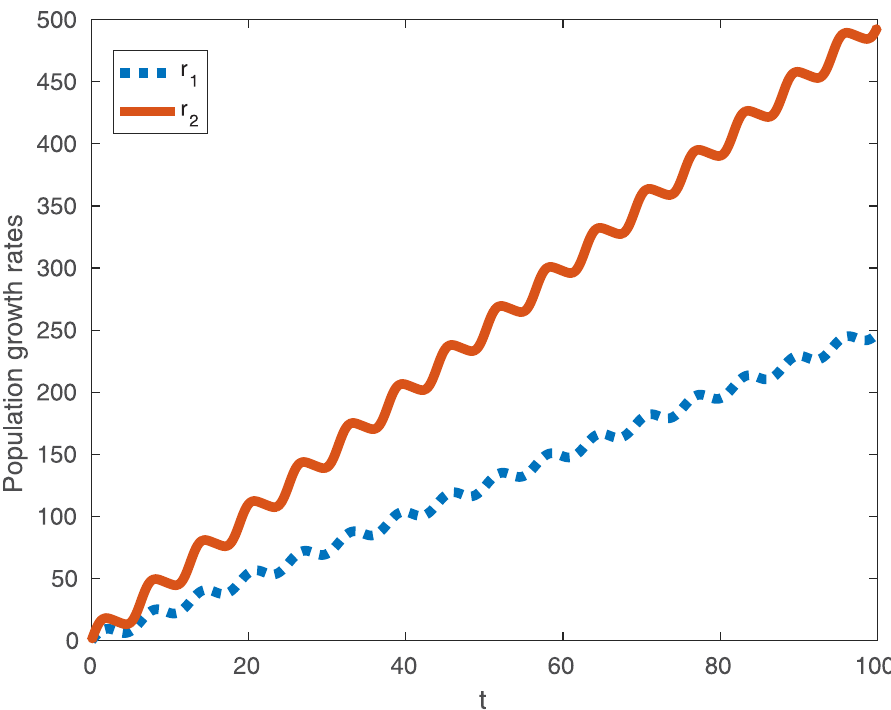
Fig 2. Typical population growth rates r 1 (dotted line) and r 2 (solid line) as a function of time when birth rates are variable and mortality is constant. Observe that r 2 > r 1 for almost all t . Here B = 5 and Γ = 2.5. In Fig 2 we present a typical plot of r (dashed line) and r (solid line) as a function of time, 1 2 showing that r > r . The precise parameter values have no significance of themselves but dem- 2 1